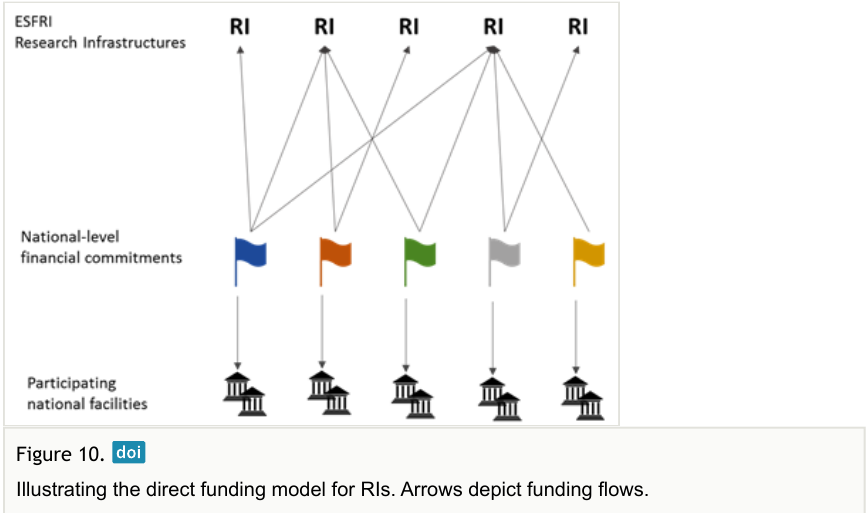
Illustrating the direct funding model for RIs. Arrows depict funding flows.